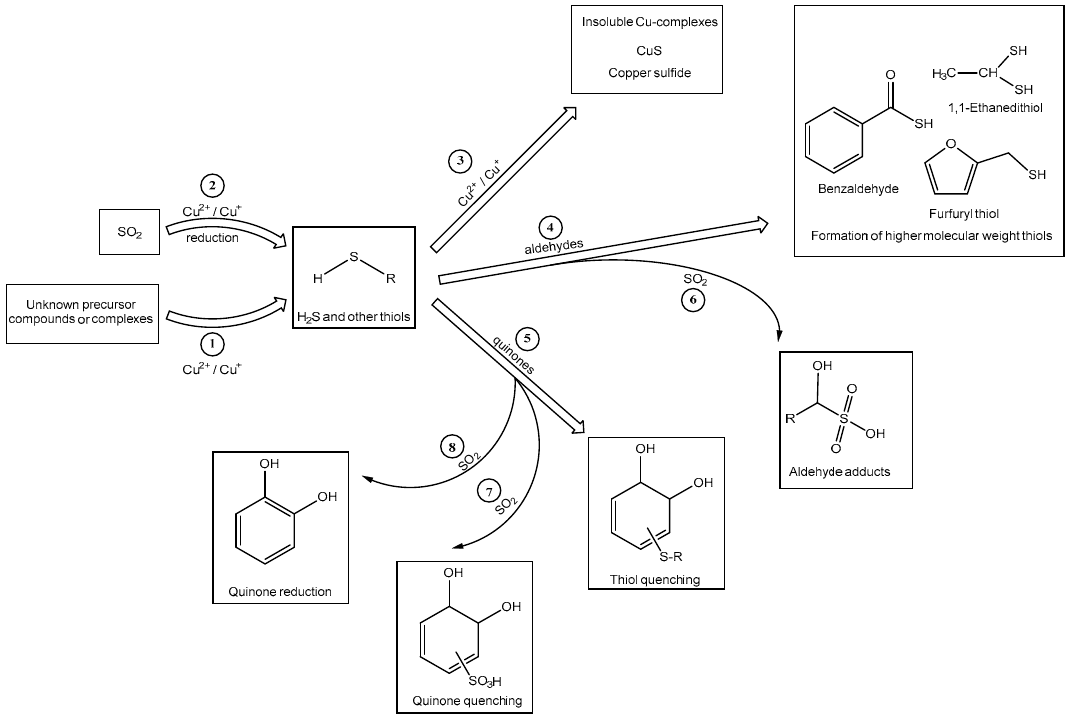
Scheme 1. Possible mechanisms for the formation of H 2 S and other low molecular weight thiol compounds and the interaction between Cu 2+ , SO 2 , and “Cu 2+ + SO 2 ” with wine compounds such as aldehydes and o-quinones, during H 2 S formation.